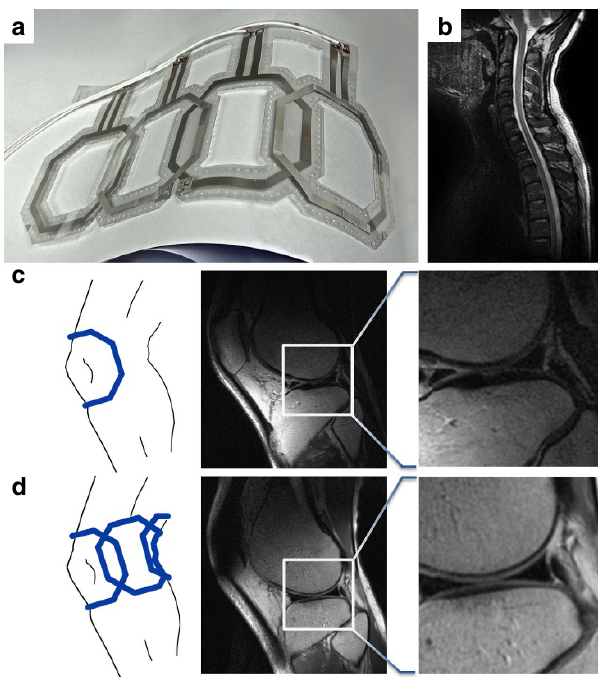
Figure 4 | In vivo imaging with flexible coil array at 3T. ( a ) Proof of concept, prototype of printed flexible four-channel receive array. ( b ) Sagittal cervical spine MRI image showing excellent penetration due to the conformity of the array. ( c ) Single-element MRI image of a knee. ( d ) Scan showing the expected improved penetration using a four-channel array wrapped around the leg of a volunteer. Highlighted areas show region of interest with higher SNR from increased field of view from